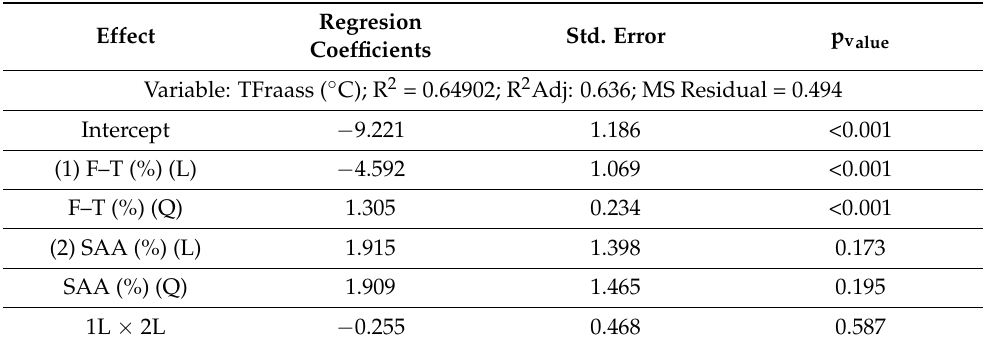
Table 6. Evaluation of the significance (ANOVA) of the factorial impact (F–T wax and SAA) on T Fraass.